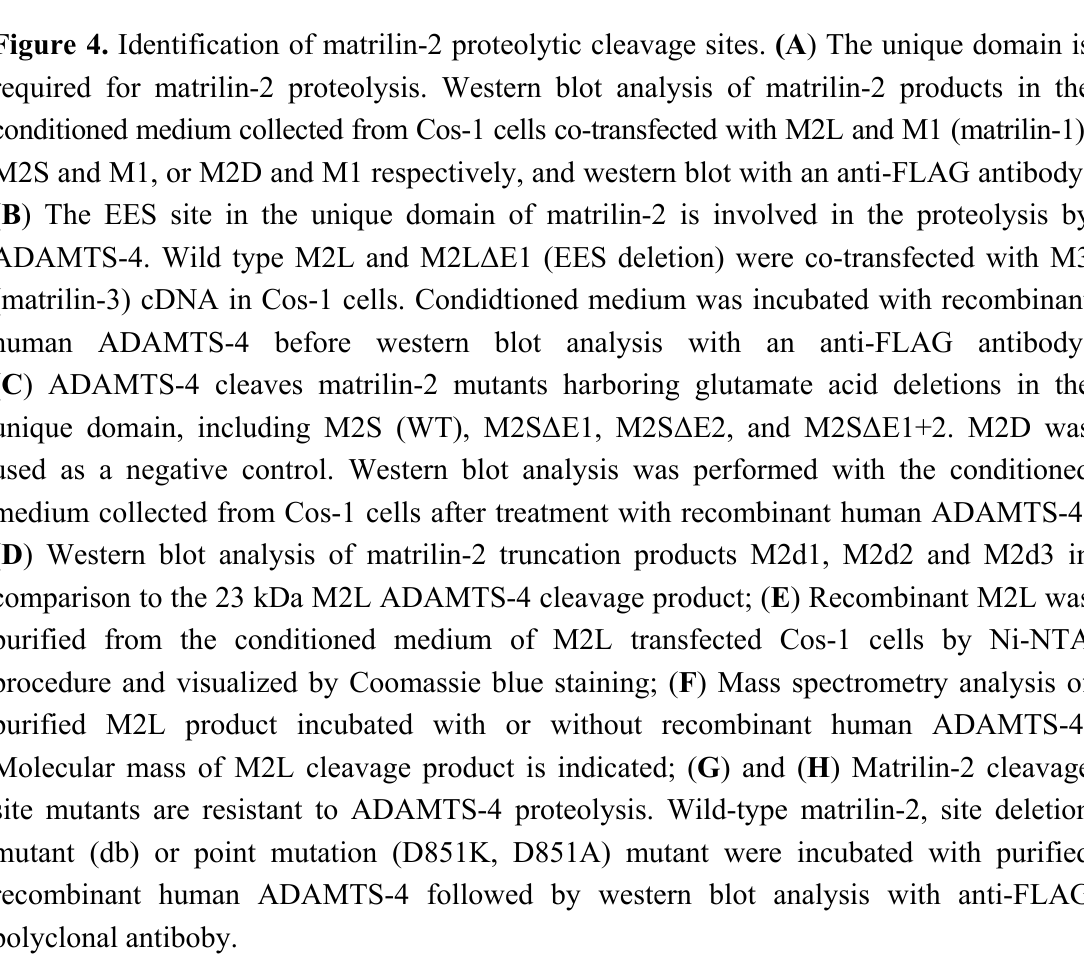
Figure 4. Identification of matrilin-2 proteolytic cleavage sites. (A ) The unique domain is required for matrilin-2 proteolysis. Western blot analysis of matrilin-2 products in the conditioned medium collected from Cos-1 cells co-transfected with M2L and M1 (matrilin-1),